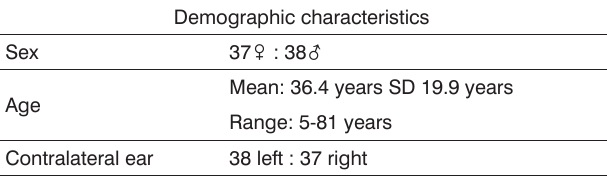
Table 1. Characteristics of the study population.